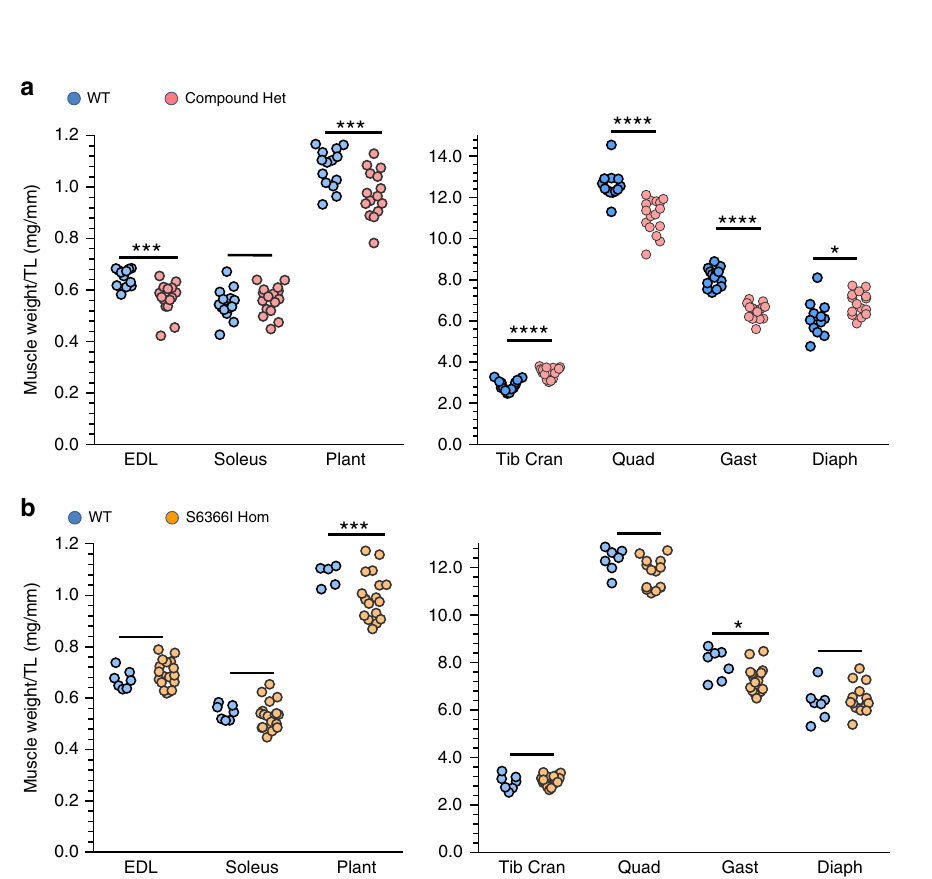
Fig. 2 Assessing muscle weights. a Compound-Het mice have decreased tissue weight in EDL, plantaris, quadriceps and gastrocnemius muscles while muscle weight of tibialis cranialis and diaphragm is increased. b Neb S6366I Hom mice have decreased muscle weight in plantaris and gastrocnemius. Number of mice in a : WT: 14, Compound Het: 16. Number of mice in b : WT: 7, and Neb S6366I Hom: 18. (Male mice (4 mo); similar fi ndings in female mice, not shown; 2-Way ANOVA with multiple comparison (multiple comparison correction (Sidak)). * p < 0.05; *** p < 0.001; **** p < 0.0001). Source data are provided as a Source Data fi le.